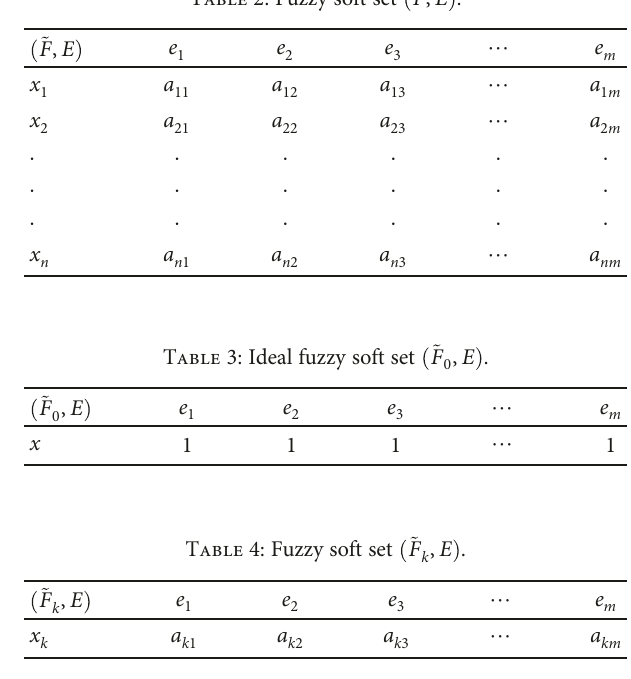
Table 5: Tabular representation of the fuzzy soft set F , A .